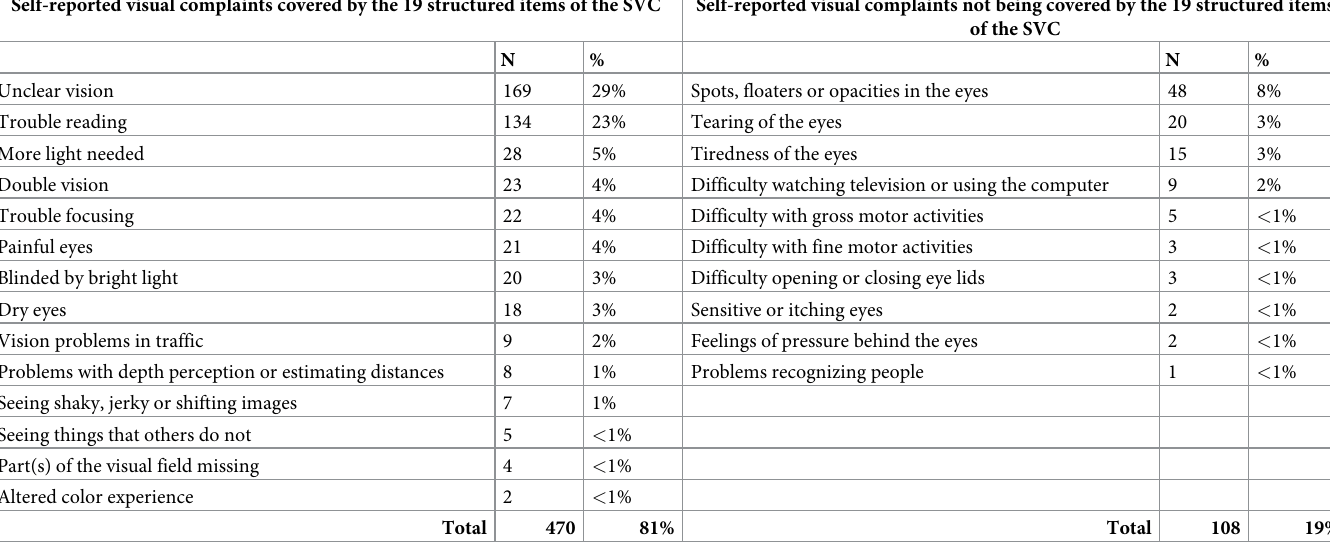
Table 2. Self-reported visual complaints on the first item of the